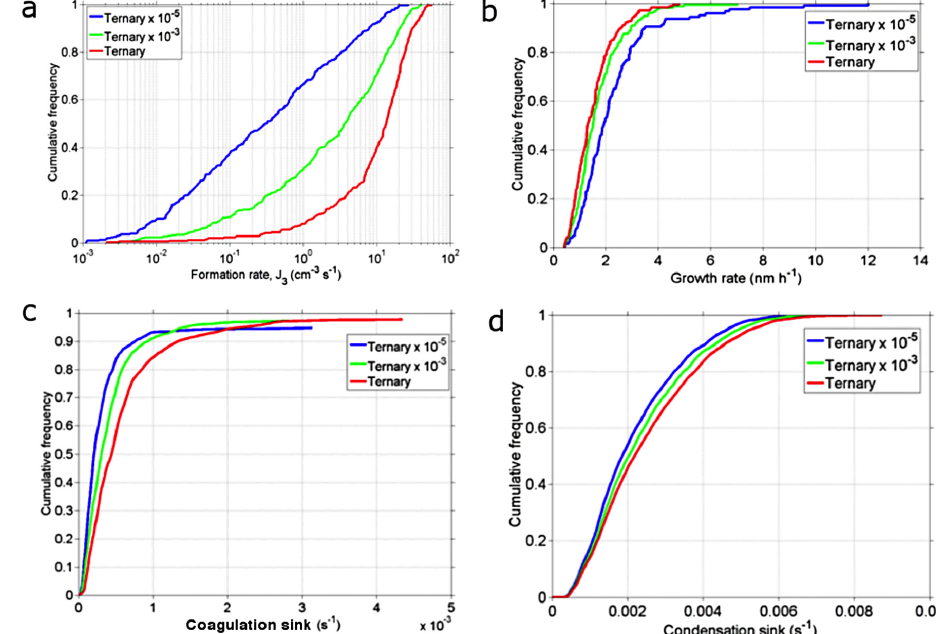
Figure 8. Cumulative distribution functions of nucleation event metrics at Hyytiälä. Red curves represent the original ternary simulation (Napari et al., 2002). Green curves represent ternary nucleation with a 10 − 3 tuning factor. Blue curves represent ternary nucleation with a 10 − 5 tuning factor. (a) 3nm particle formation rate, J 3 (cm − 3 s − 1 ) ; (b) 3–25nm growth rate, GR (nmh − 1 ) ; (c) Coagulation frequency (s − 1 ) ; (d) Condensation sink (s − 1 ) .